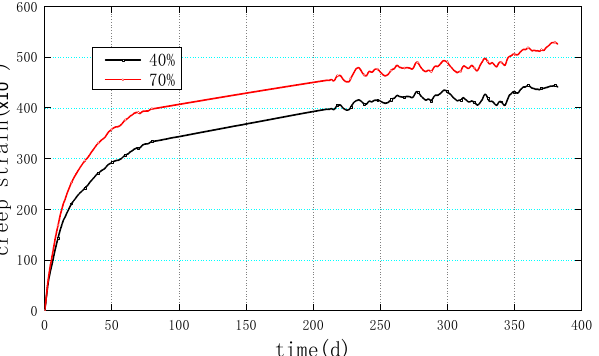
Figure 11. Evolution of reinforcement strain in the compression zone of the RC T ‐ beam for two loading levels (loading age of 7 days).